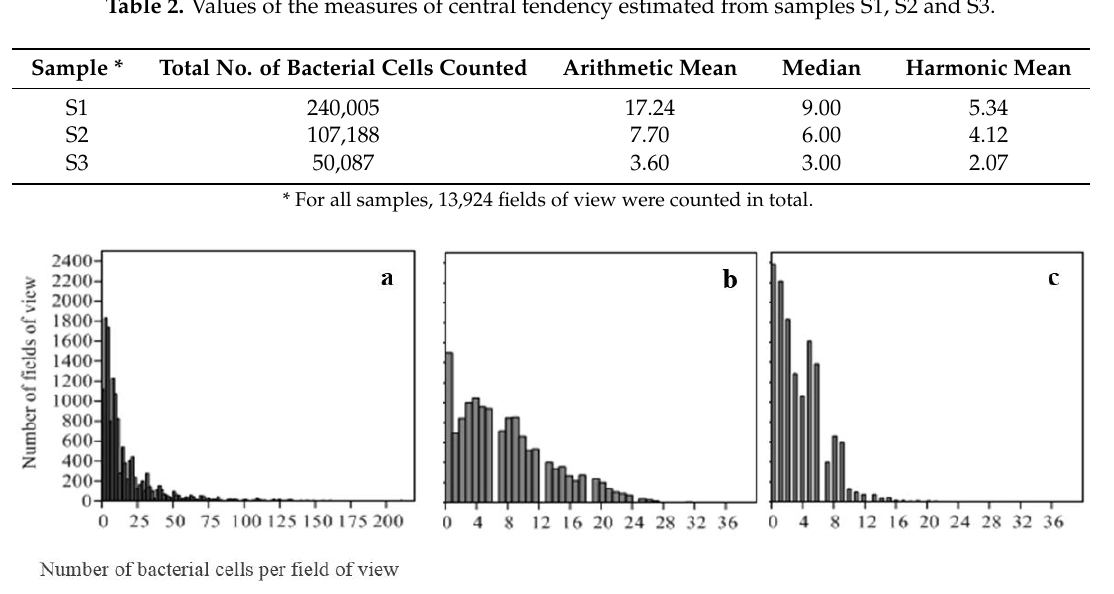
Figure 2. Relative frequency plots show the distribution of total bacterial count data for all samples, ( a ) S1, ( b ) S2 and ( c ) S3. In each plot, the number of fields of view is shown on the y -axis and number of bacterial cells per field of view is shown on the x -axis.